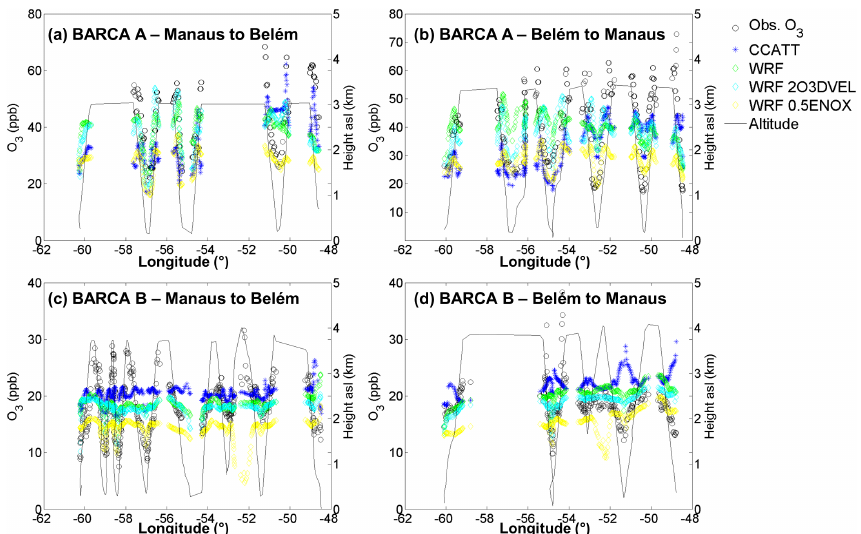
Figure 11. O 3 as observed (black circles) and simulated with CCATT-BRAMS (blue stars) and WRF-Chem (base case: green diamonds, 2DEPVEL: cyan circles, and 0.5ENOx: yellow squares) from BARCA flights from (a) Manaus to Belém on 18 November 2008, (b) Belém to Manaus on 19 November 2008, (c) Manaus to Belém on 21 May 2009, and (d) Belém to Manaus on 23 November